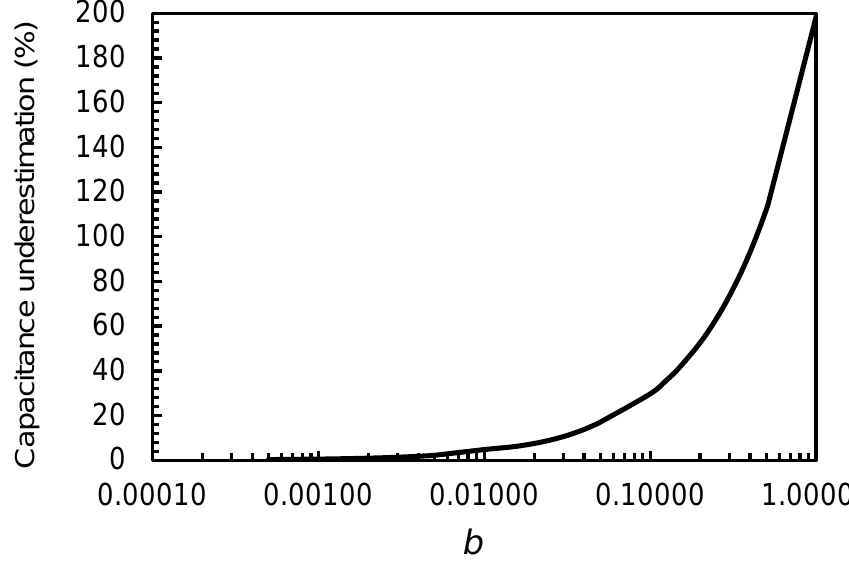
Figure 11. Underestimation of Equation (5) as a function of the aspect ratio, b , based on data in [37].